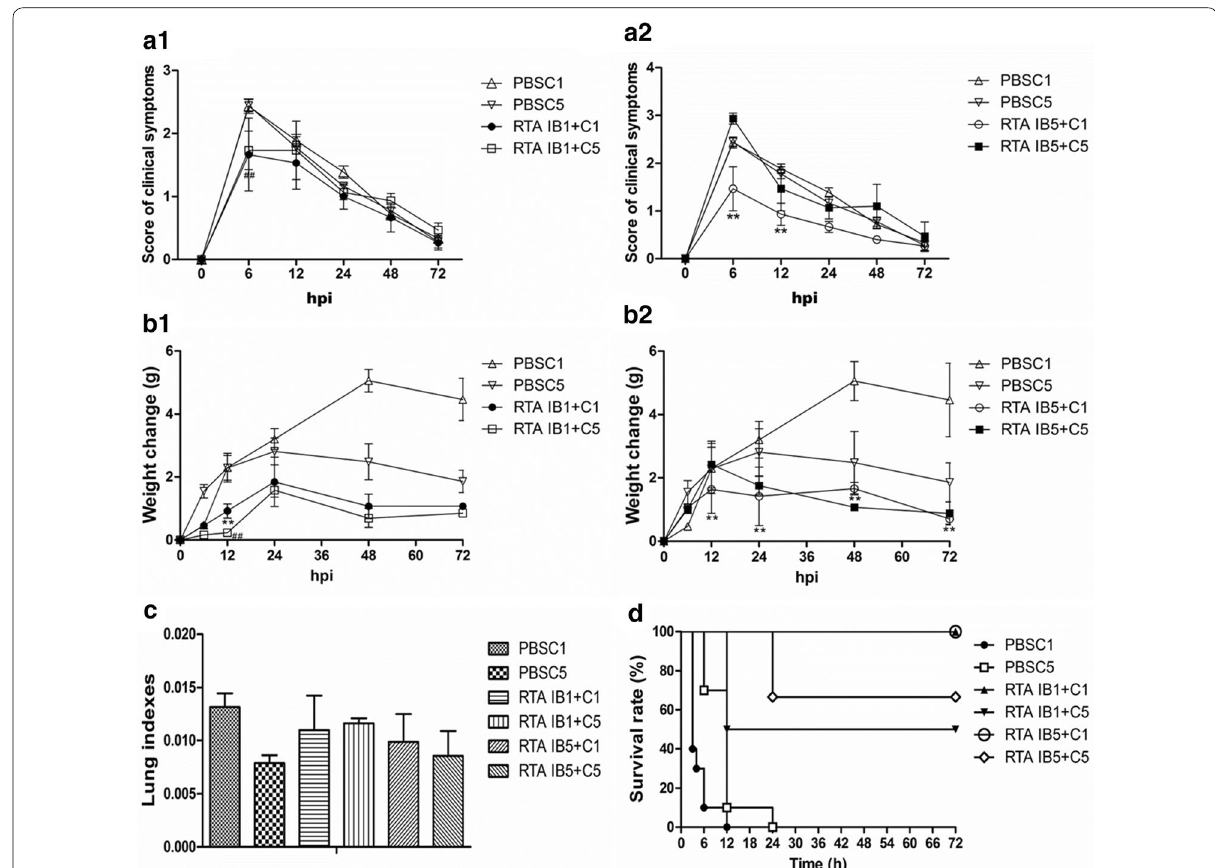
Fig. 6 Detection of the clinical symptoms, weight changes, lung indexes and survival rates of mice. a1 , a2 The clinical symptoms of each mouse were observed and scored at 0, 6, 12, 24, 48 and 72 h after challenge. b1 , b2 The weight of each mouse was recorded at 0, 6, 12, 24, 48, and 72 h after challenge, and the weight changes of the mice were calculated (weight changes the initial weight- the real-time weight); * represents the = RTA IB1 C1 group or the RTA IB5 C1 group compared with the PBSC1 group and was statistically significant; # represents the RTA IB1 C5 group + + + or the RTA IB5 C5 group compared with the PBSC5 group and was statistically significant. * or #, P < 0.05; ** or ##, P < 0.01. c The body weight and + the lung weight of the mice were recorded at 72 h after challenge, and the lung indexes of the mice were calculated. d . The survival rates of the mice immunized with PBS, RTA protein combined with inactivated APP1 or APP5b at 0, 14, and 28 d and challenged with APP1 and APP5b separately at 35 d. The mice were observed for 3 d to record the survival